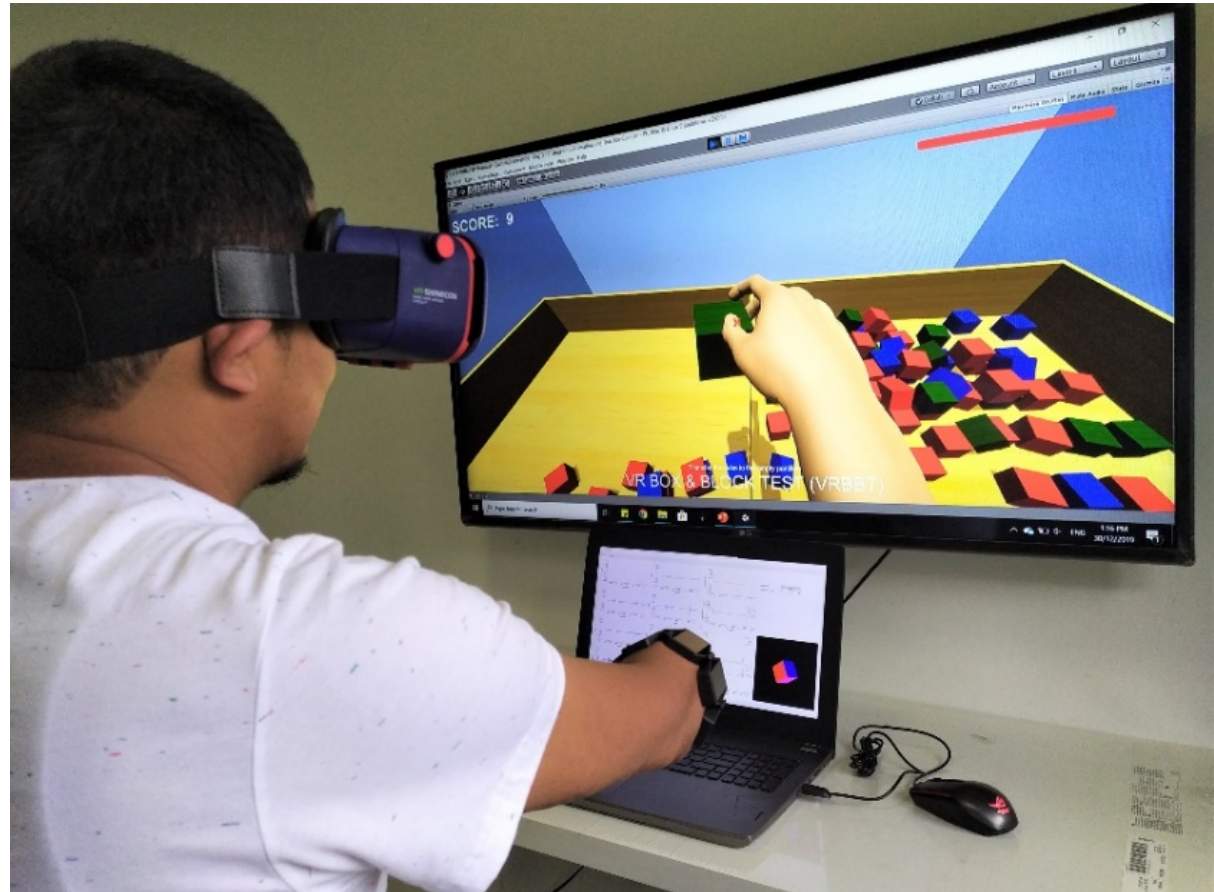
Figure 2. A transradial amputee participant performing the virtual box and block